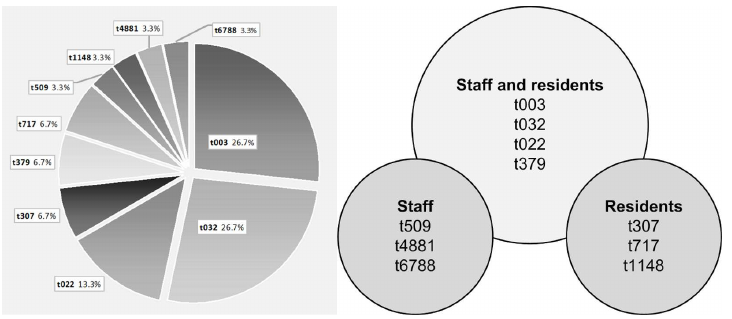
Fig 2. Spa typing: summary of the confirmedMRSA-positive results (A) and distribution of spa types among staff and residents (B).